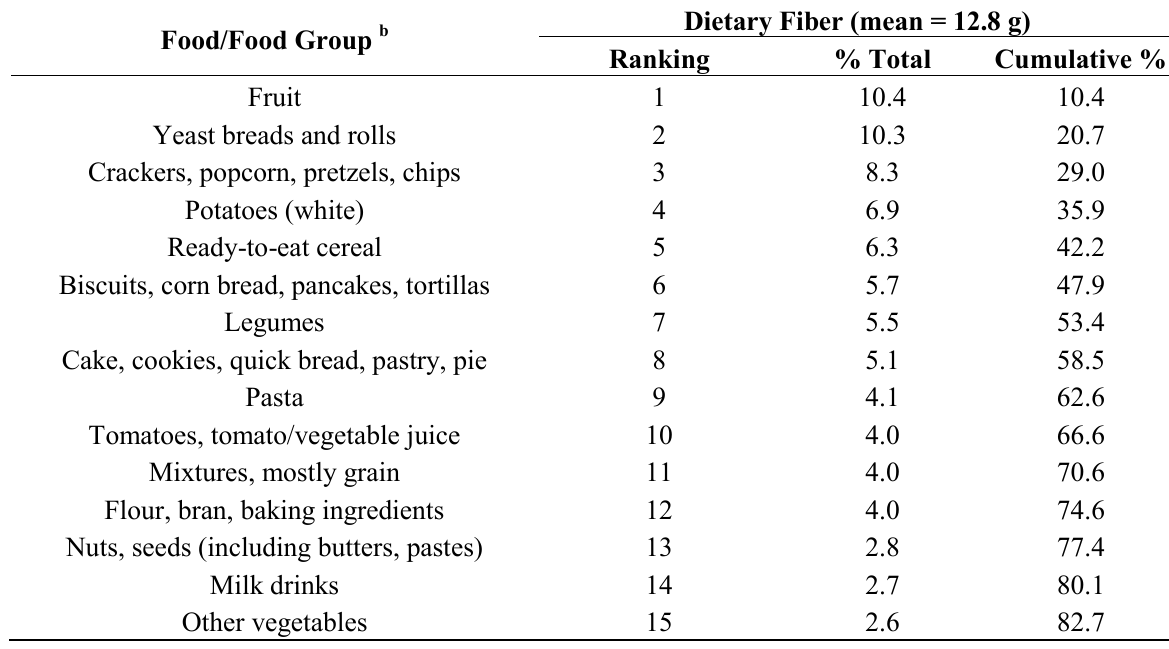
Table 6. Food/Food group sources of dietary fiber among US children aged 2–18 years (from NHANES 2003–2006) a